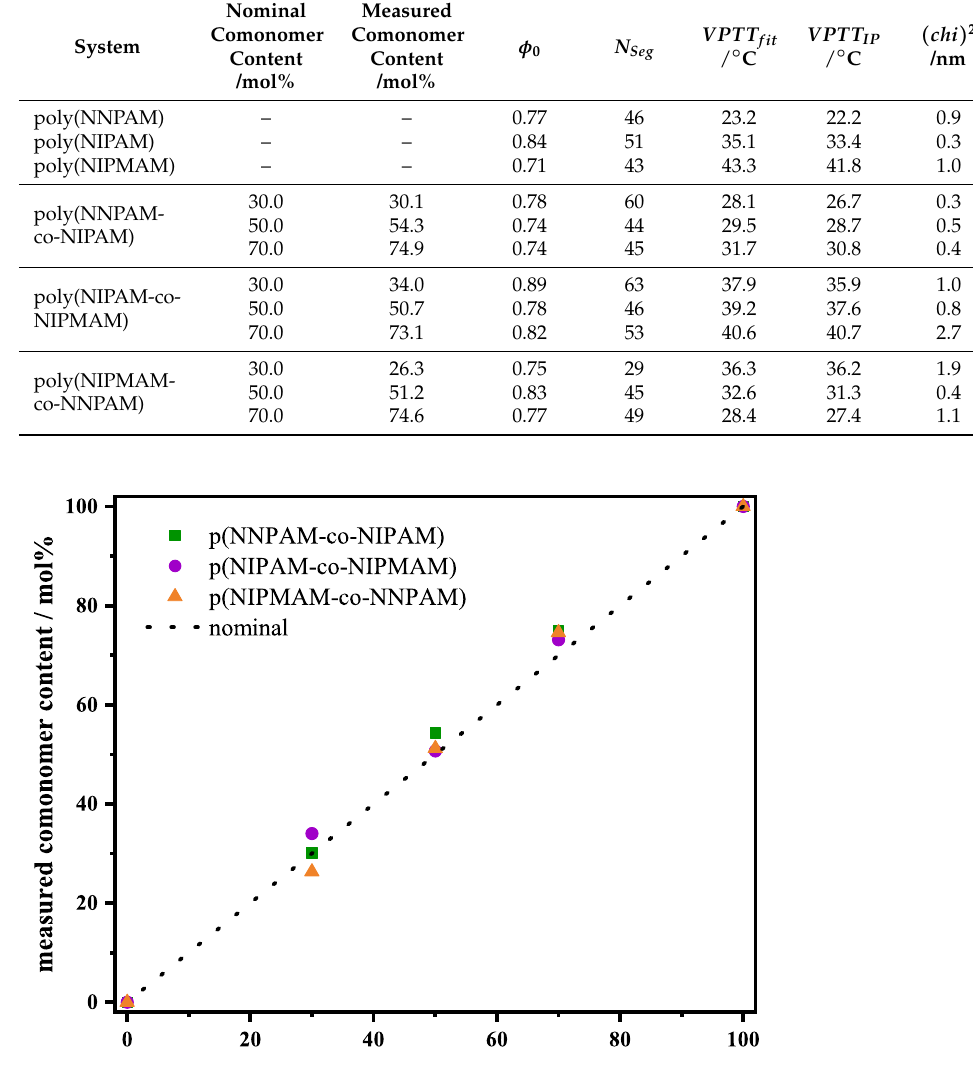
IP ) determined from the